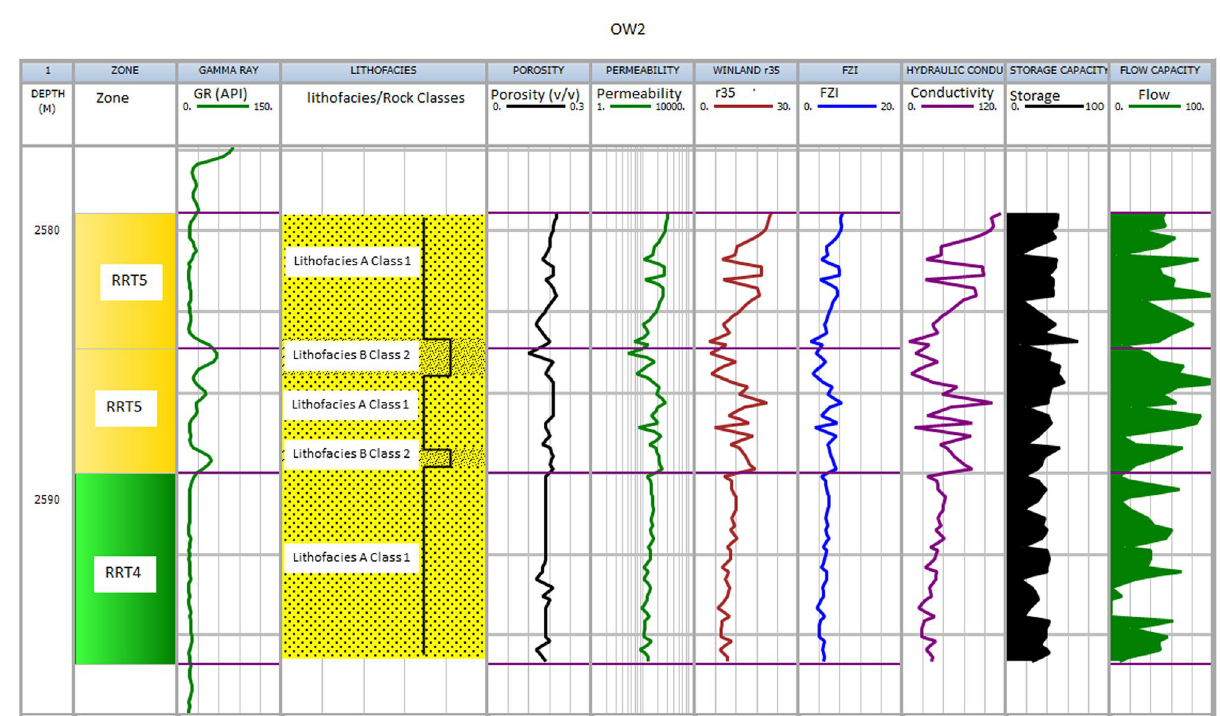
Figure 10. Shows the results for well OW2. Track 1 shows the measured depth. Displayed in tracks 2–9 are flow zones, Gamma ray log, lithofacies, porosity, permeability, Winand r35, Flow zone indicator, and hydraulic